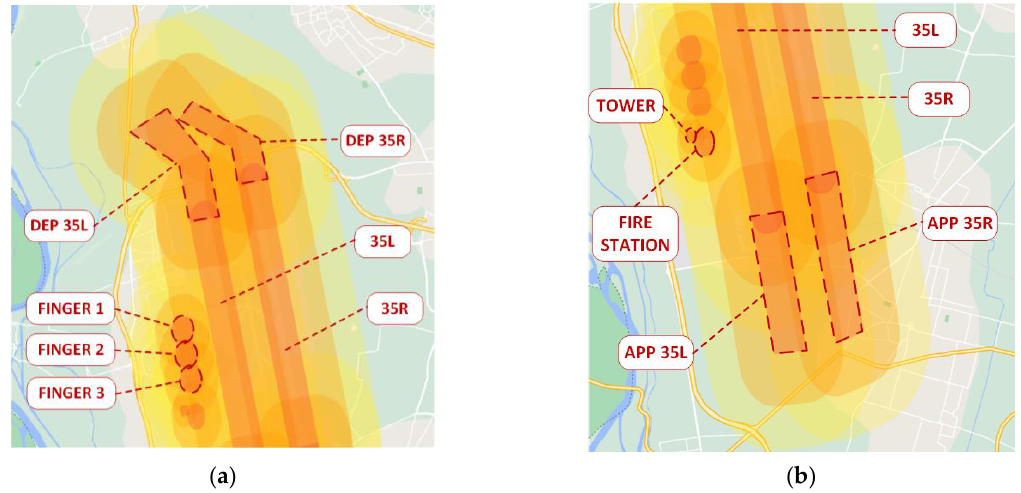
Figure 13. Displacement of counter-drone alerting zones of stationary assets for solution scenarios.